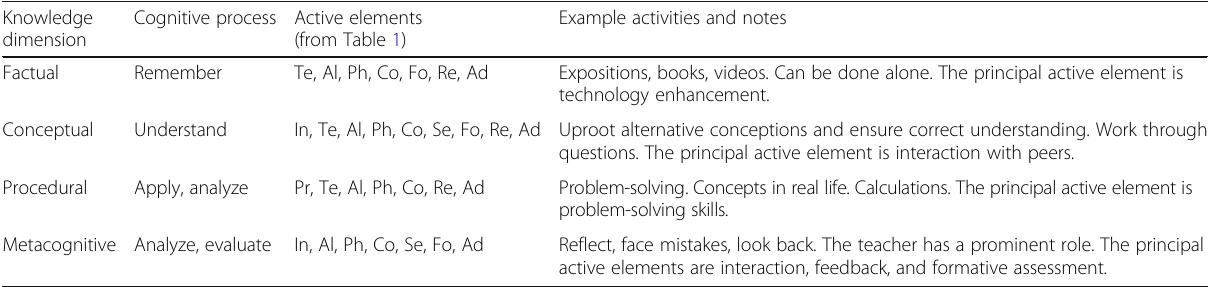
Table 2 Sketch for a four-step study process. Here, the elements of active learning from Table 1 are identified and assigned to the study process of Fig.